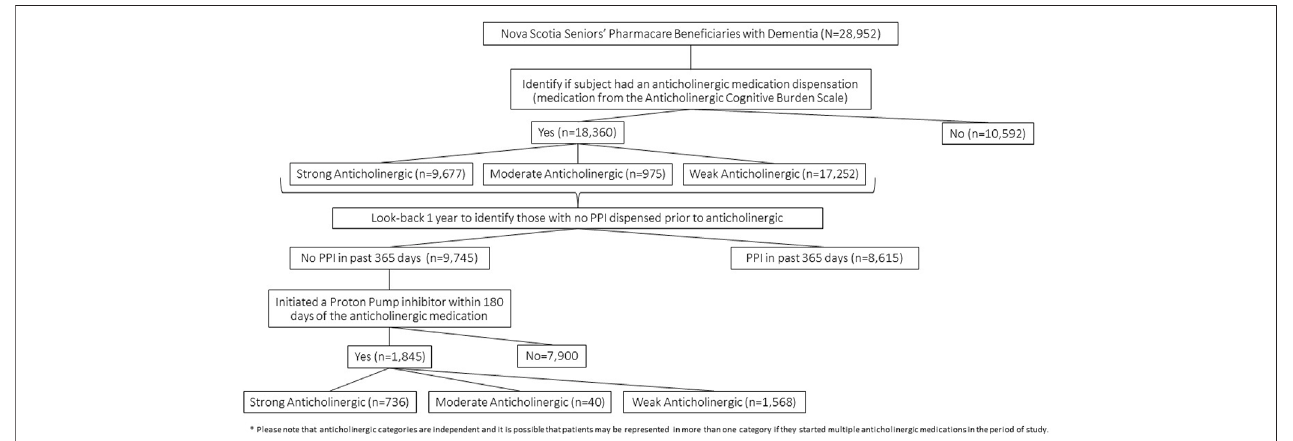
FIGURE 1 | Patient fl ow through study analytic procedure.